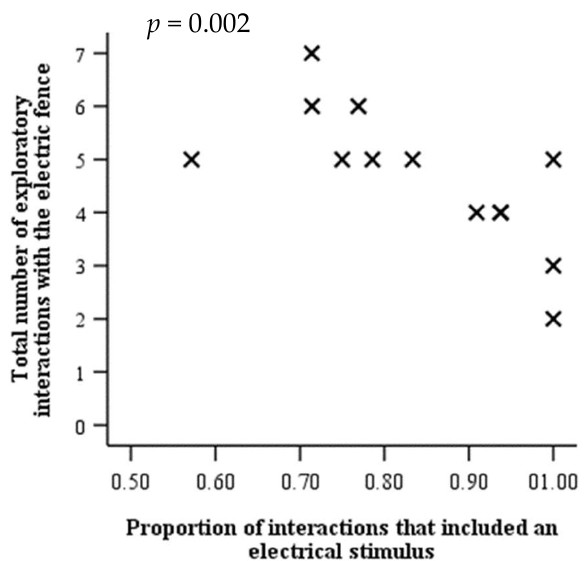
Figure 5. Scatterplot showing the correlation p -value and relationship between the number of exploratory interactions with the electric fence per heifer (total over 6 days of strip-grazing) and the proportion of interactions with the virtual fence during associative training that included an electrical stimulus.